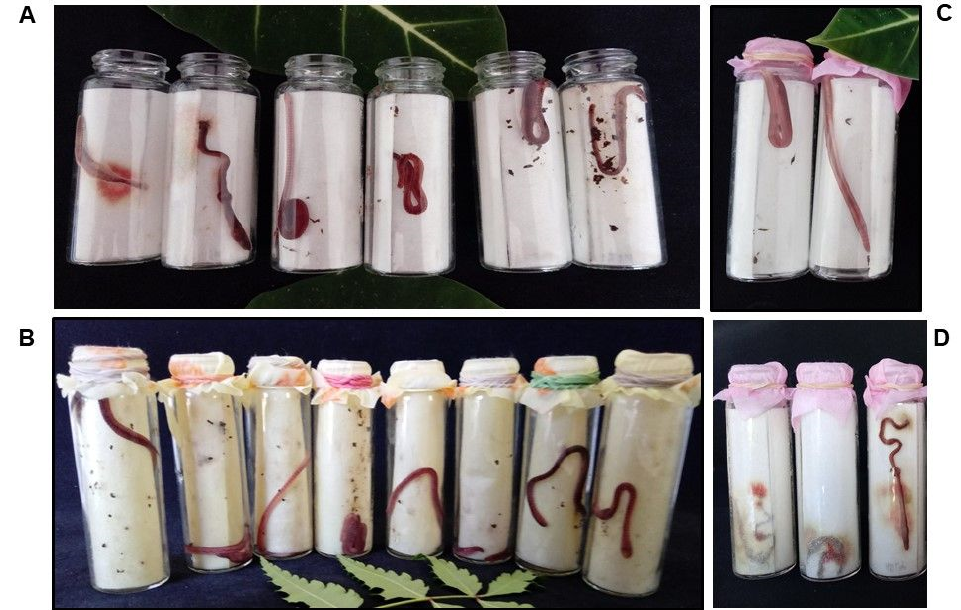
Figure 3. Acute contact ecotoxicity assay of ( A ) Alseis yucatanensis (1 mL, 3% w / v ); ( B ) Helicteres baruensis (1 mL, 6% w / v ), ( C ) water (1 mL), ( D ) oxamyl (1 µL/mL) using filter paper (49.92 cm 2 ) and Eisenia fetida .